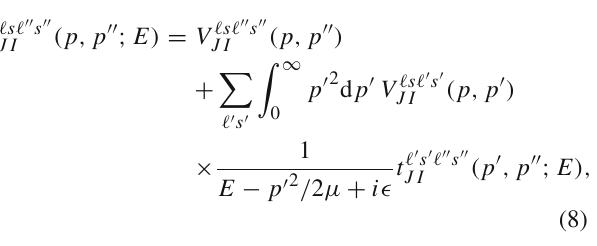
, s (cid:3) ) and (cid:2) c N channels c c